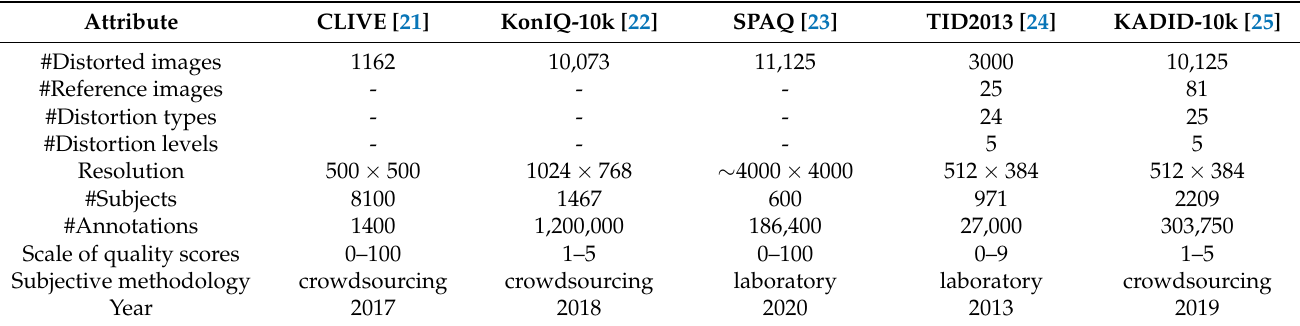
Table 1. The main characteristics of the applied IQA benchmark